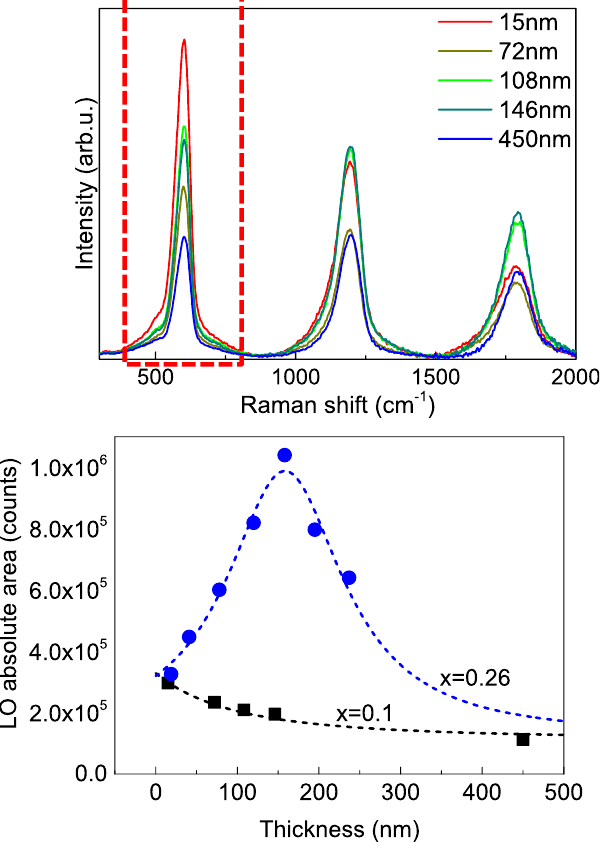
Figure 5. Top: Raman spectra measured from series (ii) layers with Mg/(Mg + Zn) relative content 10% and different layer thicknesses. Bottom: Integral intensity of the main LO peak (highlighted in red in the Raman spectra plotted in Fig. 4 top) versus layer thickness for layers series (ii) (Mg/(Mg + Zn) relative content 10%) and layers series (iii) (Mg/(Mg + Zn) relative content 26%). Dotted lines are added as guide for the